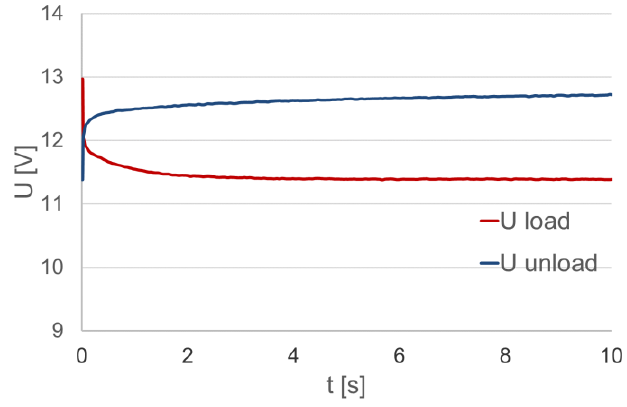
Figure 3. The voltage at the loaded (U load ) and unloaded (U unload ) battery terminals.